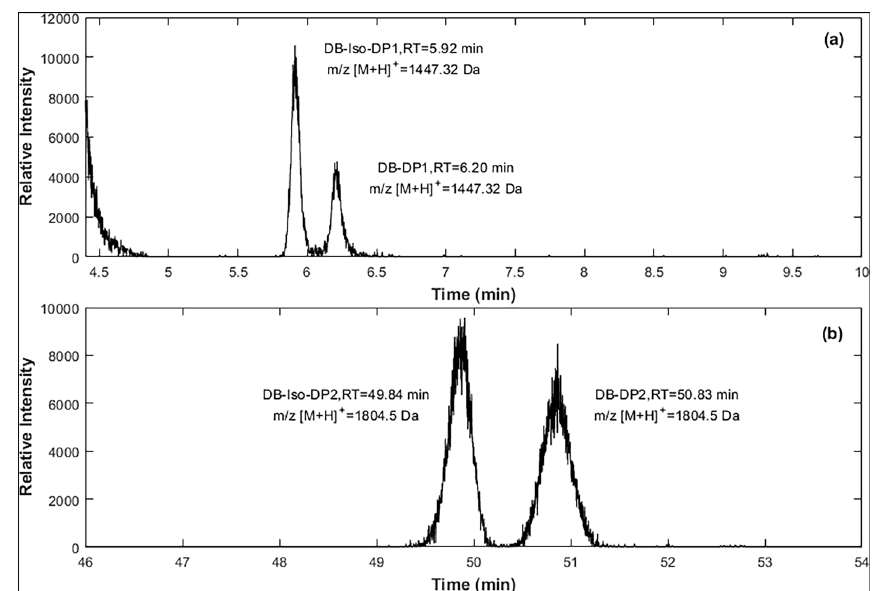
Fig. 5 a Extracted ion chromatograms obtained from heat-stressed dalbavancin in acetate buffer of a the two ions at m/z [M reproducing the LC peaks corresponding to compounds 2 and 3, DB-Iso-DP1 and DB-DP1, respectively, and b the two ions at m/z [M H] + 1804.5 Da, reproducing the LC peaks corresponding to compounds 7 and 8, DB-Iso-DP2 and DB-DP2, respectively + =